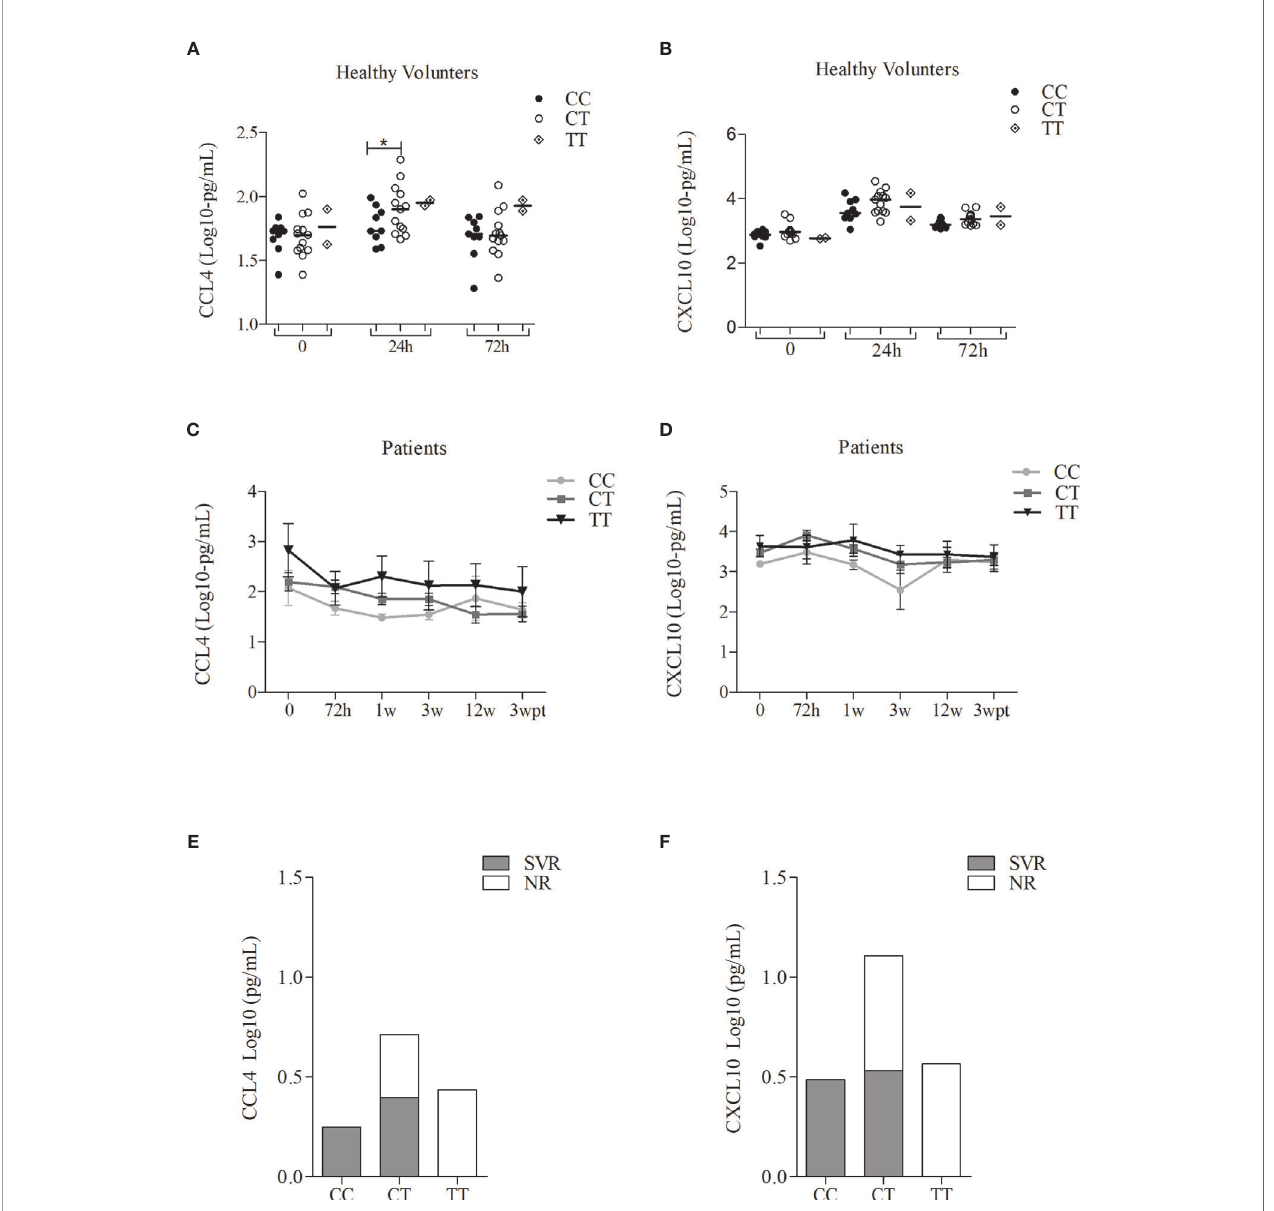
FIGURE 5 | Serum levels of the CCL4 and CXCL10 of the patients with CHC treated with Peg-IFN a /RBV and healthy volunteers who received one dose of Peg- IFN a strati fi ed by rs12979860 genotypes. (A) CCL4 in healthy volunteers; (B) CCL4 in patients; (C) CCL4 levels before treatment in patient responders and non- responders; (D) CXCL10 in healthy volunteers; (E) CXCL10 in patients; (F) CXCL10 levels of the fi rst week of treatment in patient responders and non-responders. Number of the genotypes in patients CC (n = 3), CT (n = 17) and TT (n = 4) and in health volunteers CC (n = 9), CT (n = 13) and TT (n = 2). Data were compared by the two-way ANOVA, plus post-hoc comparisons adjusted by the Sidak procedure (*P < 0.05). Results are represented as medians. h, hours; w, week; wpt, week post-treatment. Serum levels of other cytokines analyzed did not present statistically signi fi cant